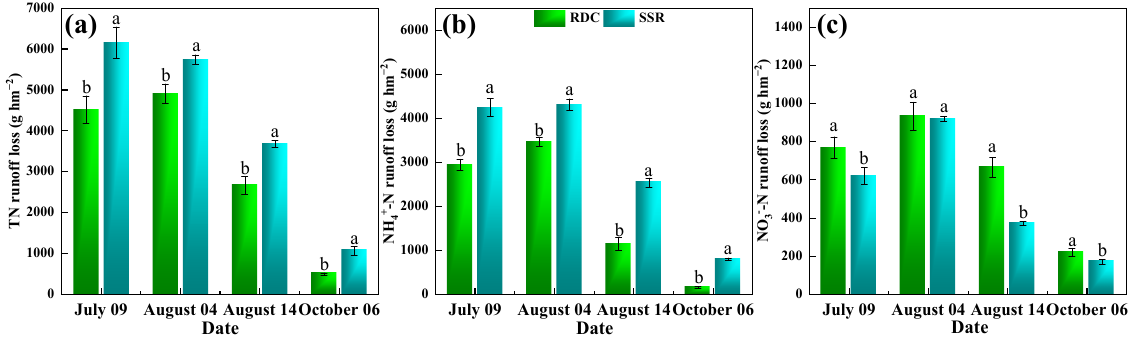
Figure 7. Nitrogen losses via runoff. ( a ) TN is total nitrogen, ( b ) NH 4+ -N is ammonium nitrogen, ( c ) NO 3 − -N is nitrate nitrogen. Small letters show the significant difference.